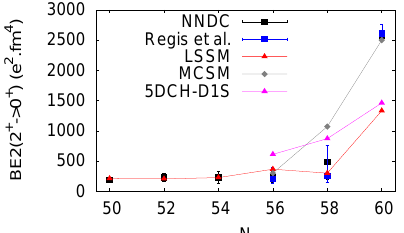
Figure 12. E 2 reduced transitions probabilities as obtained within the present framework in com- parison to available data and other models’ predictions. The LSSM value at N = 60 is obtained in a fixed configuration calculation; see the text for details. The MCSM and 5DCH-D1S values are those reported along with the data in